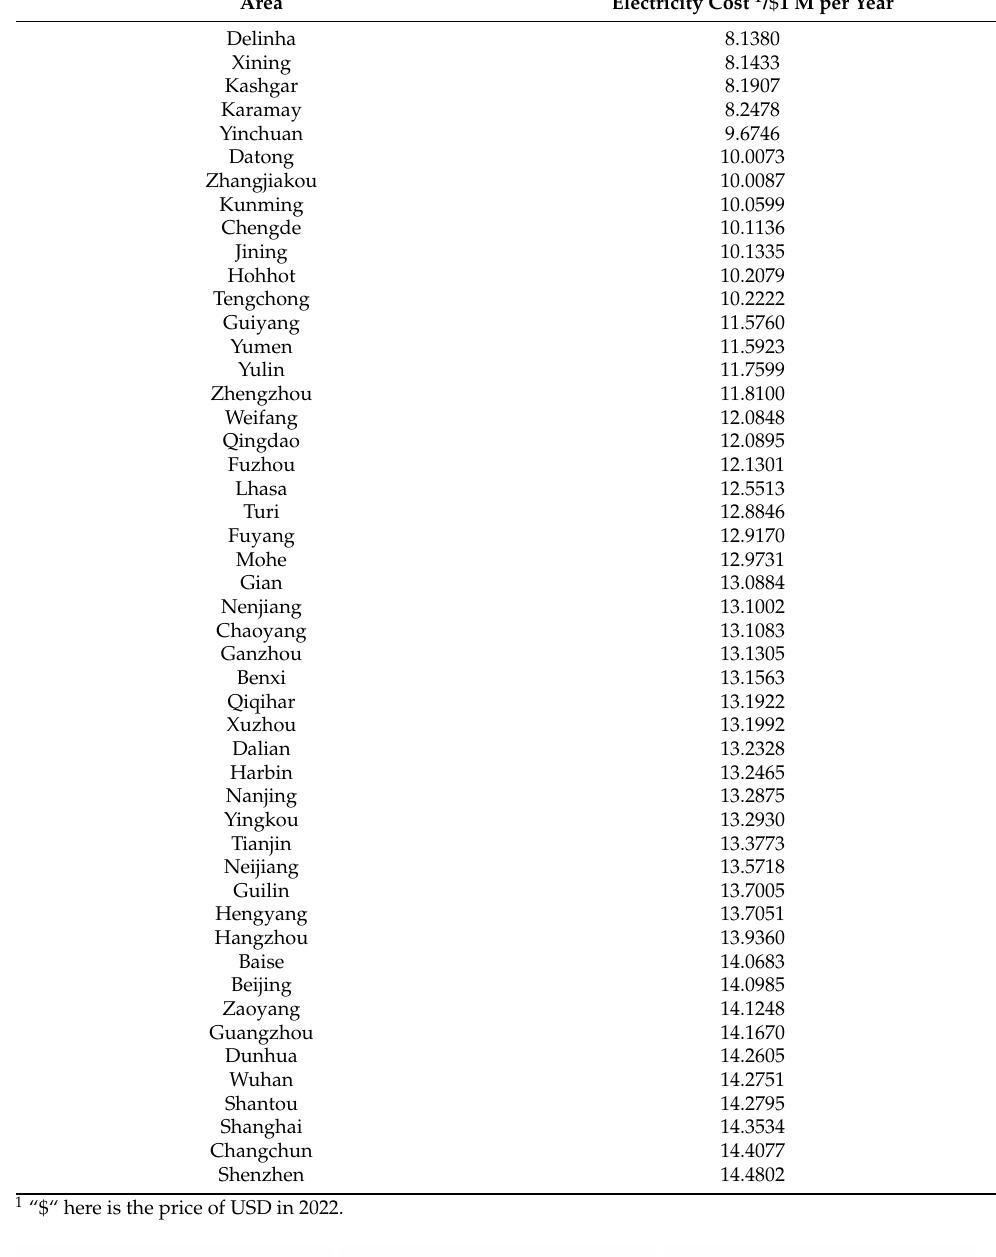
Table A3. Estimated average annual electricity cost of data centers in various regions.